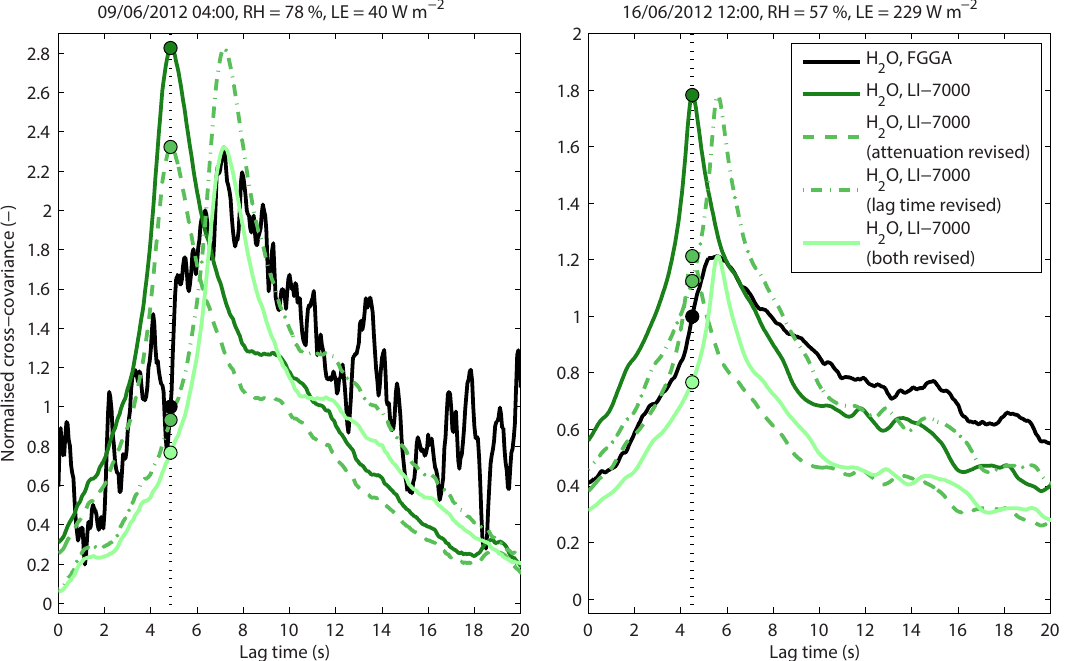
Figure 10. Two examples of cross-covariances between w and H 2 O (FGGA) and H 2 O (LI-7000). Location (lag time) and amplitude (atten- uation) of H 2 O (LI-7000) cross-covariance are adjusted in order to replicate H 2 O (FGGA) cross-covariance. H 2 O cross-covariances were normalised with the values that should be used in Eq. (5) in order to illustrate the magnitude of the relative error made in density and spec- troscopic corrections (Eq. 5) if different values for w 0 χ 0 v are used. The dots show the values which would be used in the correction (Eq. 5). Vertical dotted lines show the CH 4 lag